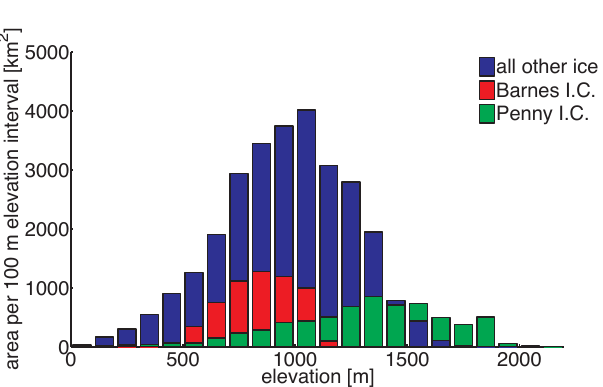
Fig. A5. Glacier hypsometry for the Barnes Ice Cap, Penny Ice Cap, and all remaining glacier ice on Baffin and Bylot Island.